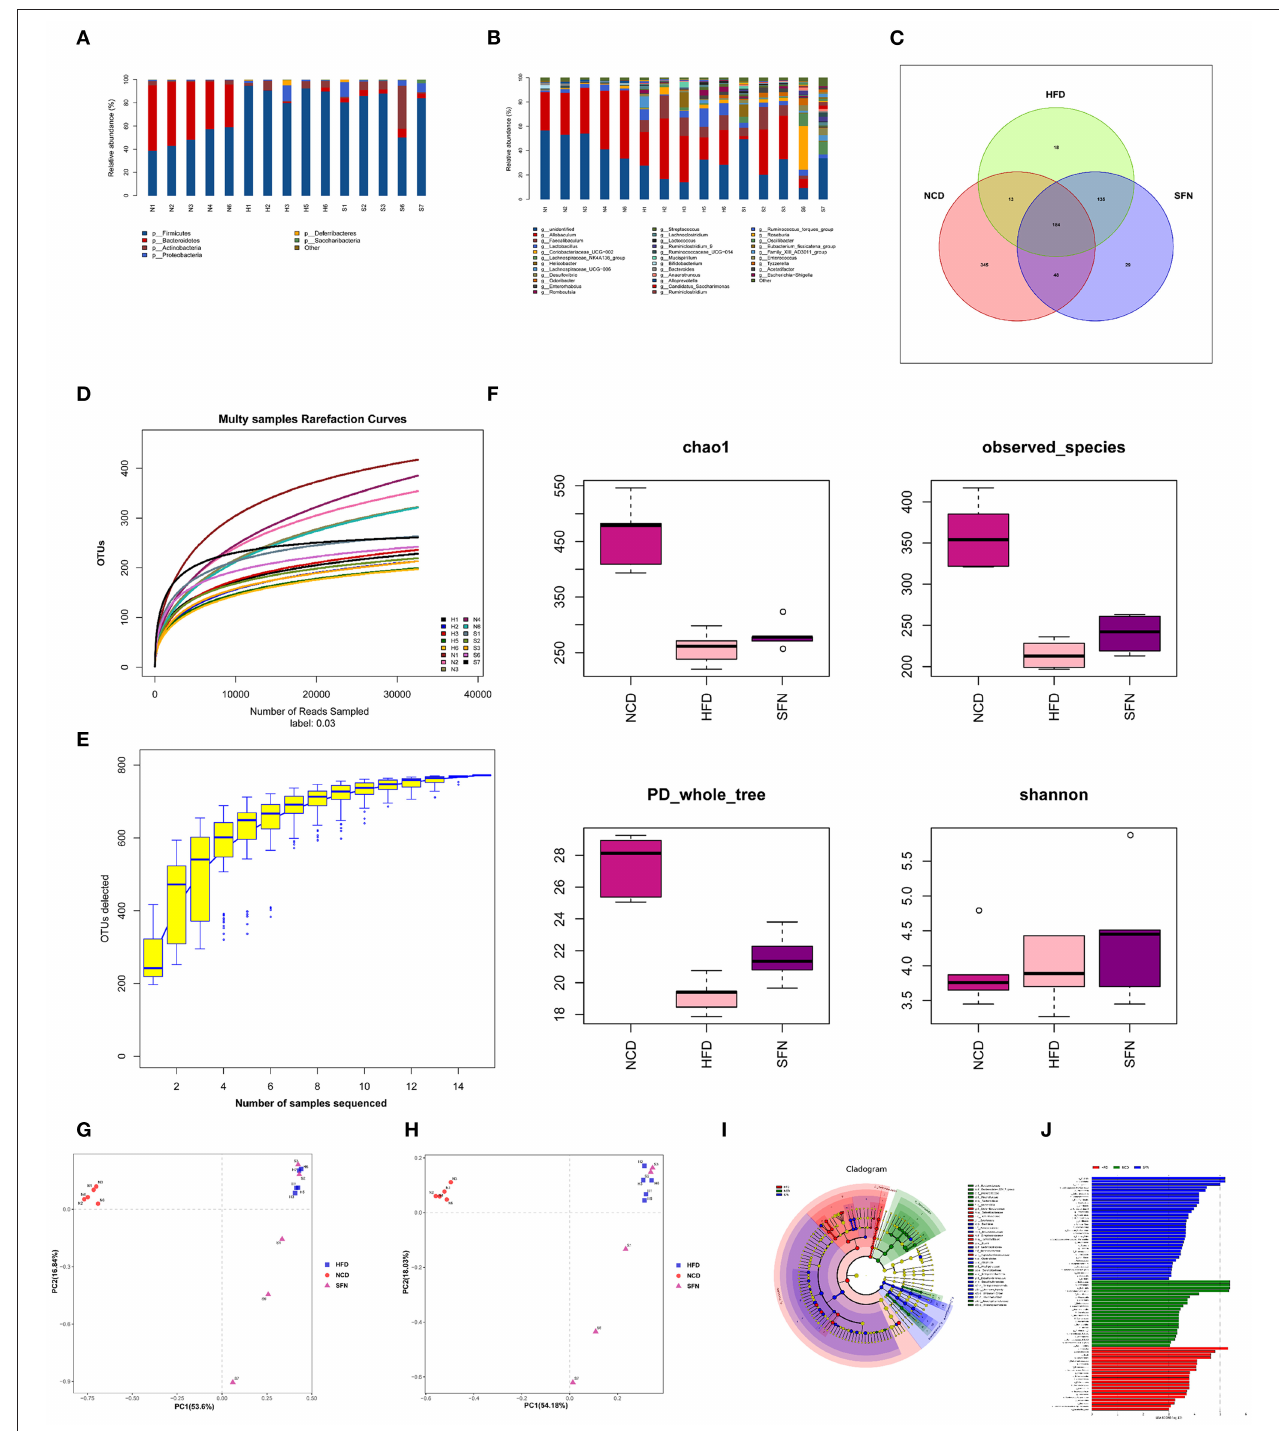
FIGURE 4 | SFN intervention manipulated the gut microbiota composition in HFD-fed mices, five animals from each group were analyzed. (A) At phylum level. (B) At genus level. (C) Venn diagram representation of the number of OTUs at the genus level from the NCD, HFD, and HFD + SFN group. (D) The rarefaction curves, (E) Species accumulation curves, (F) Chao1, Observed_species, PD_whole_tree, Shannon. (G) PCA based on the relative abundance of OTUs. (H) PCoA score plot based on Unifrac and Bray–Curtis. (I) Taxonomic cladogram derived from LEfSe analysis. (J) The species with LDA scores higher than the set value 3.